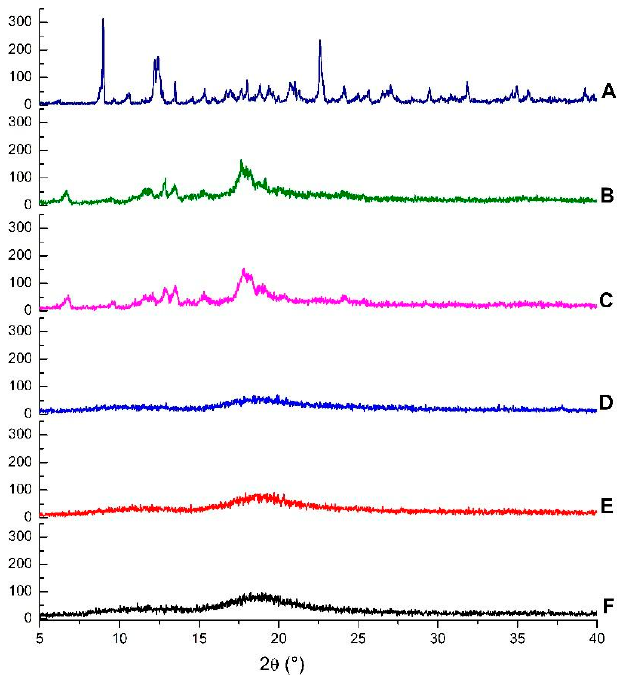
Figure 4. Diffractograms of β -cyclodextrin ( A ), EOO- β -cyclodextrin inclusion complexes prepared by kneading ( B ) and slurry ( C ), hydroxy-propyl- β -cyclodextrin ( D ), and EOO-hydroxy-propyl- β